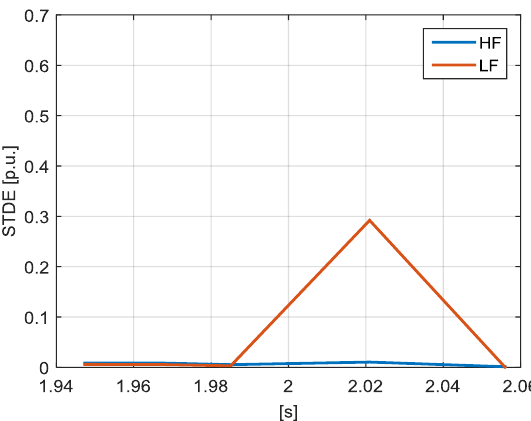
Figure 40. Case study 3: STDE at low-frequency (0 ÷ 2.4 kHz, red line) and at high-frequency (2.4 ÷ 150 kHz, blue line) obtained through Prony’s method.